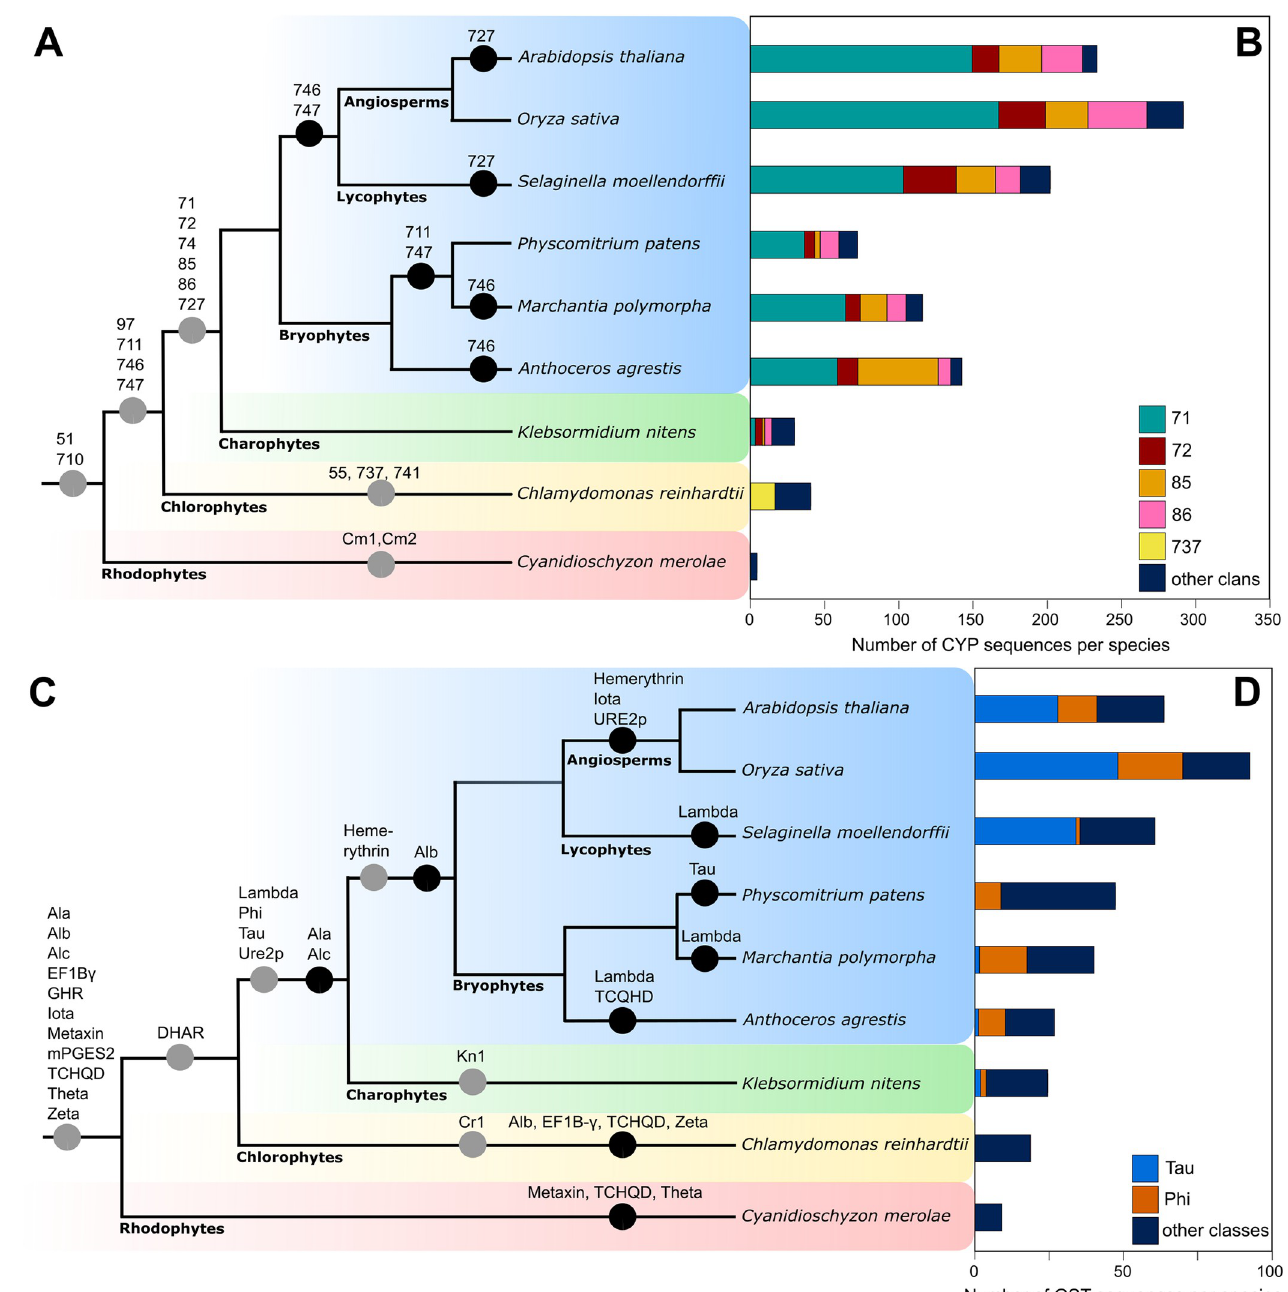
Fig 2. Four CYP clans and two GST classes expanded during land plant evolution. Cladogram of Archaeplastida phylogeny showing CYP clan (A) and GST class (C) origins and losses in plants. Grey circles represent first appearance of a clan or class, black circles represent the absence of a clan or class in a particular lineage. Numbers of CYP proteins in each species showing increases in the sizes of four of the five CYP clans shown (B) and of two GST classes (D) during land plant evolution.